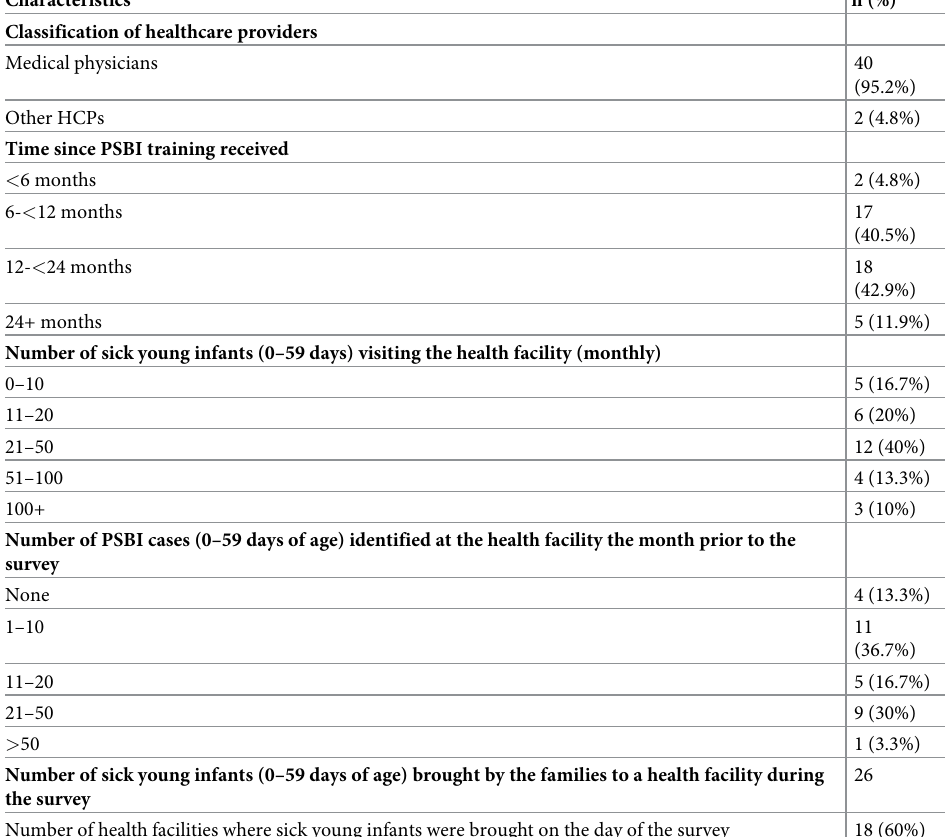
Table 2. Descriptive characteristics of HCPs (n = 42) and PSBI cases at health facilities (n = 30).